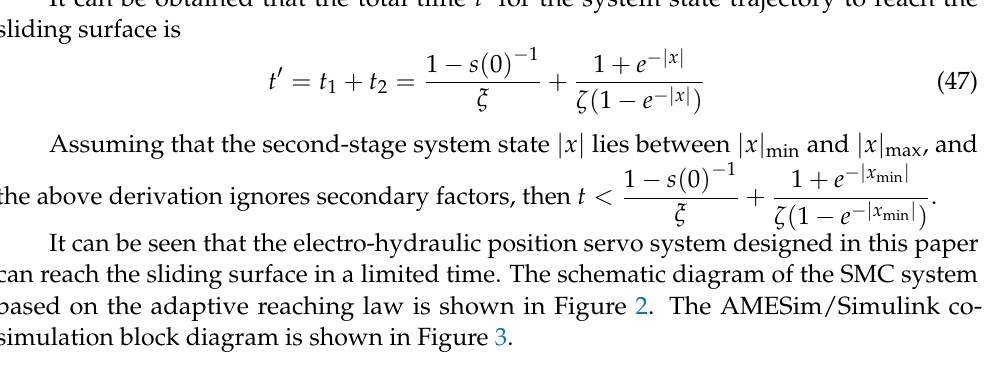
0 MPa Table 2. Parameters of adaptive reaching law SMC algorithm. Name